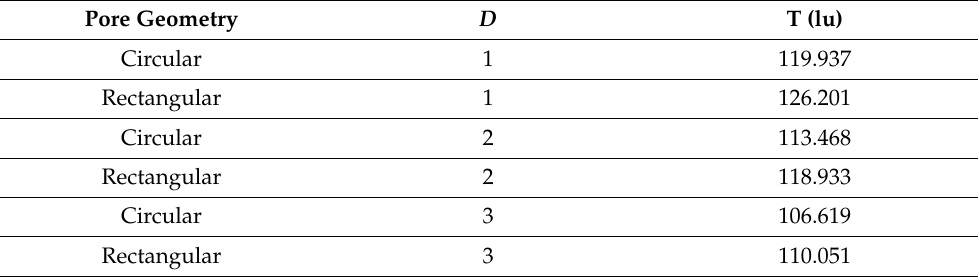
Table 4. Comparison of effective penetration length T for different pore geometries at different D and t ∗ = 0.275.